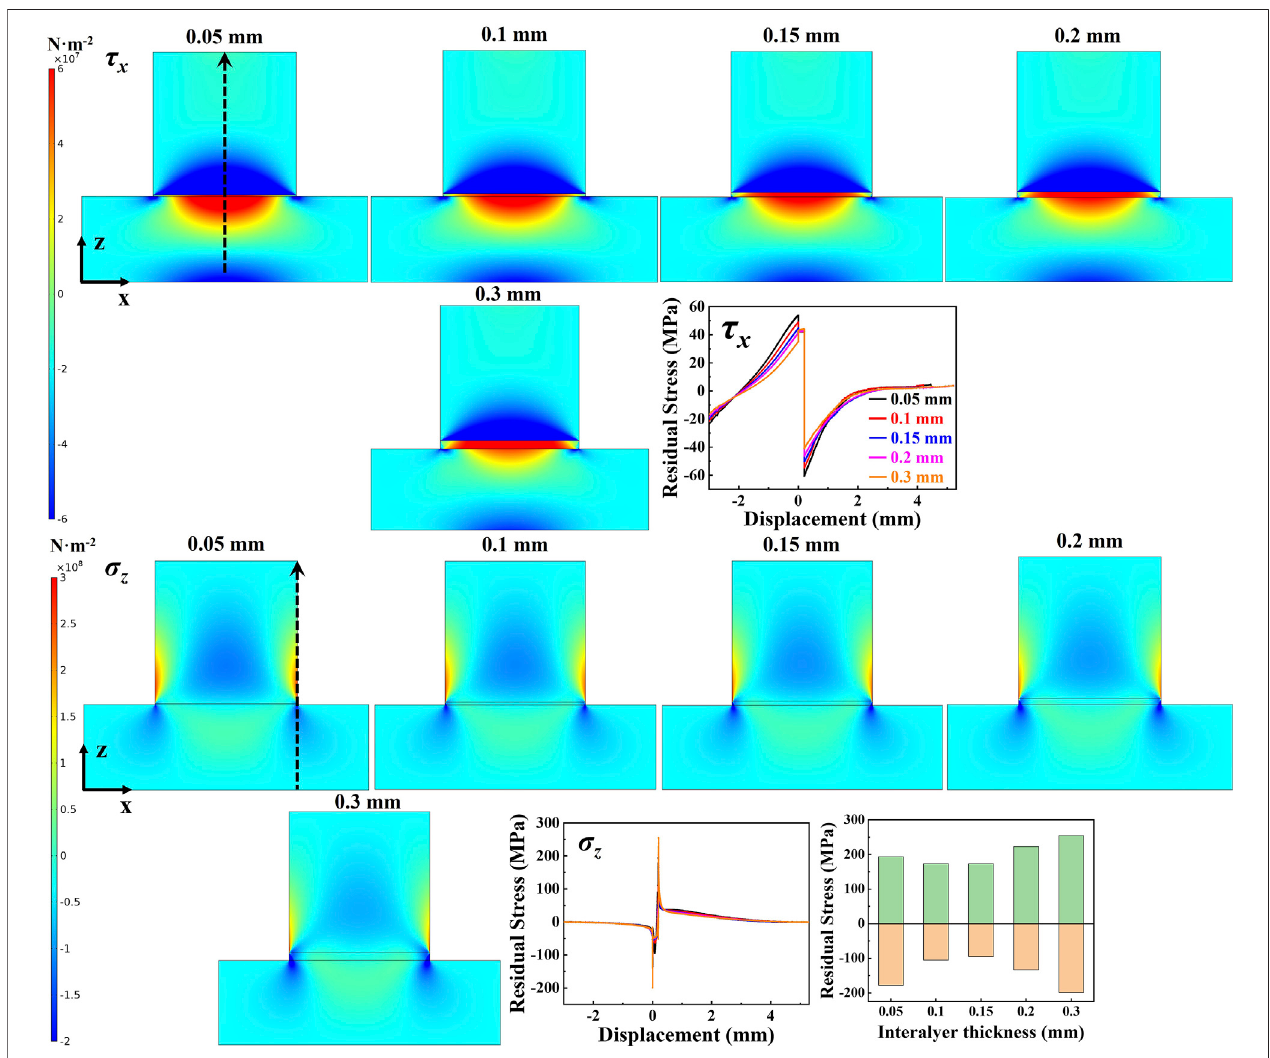
FIGURE 4 | τ x and σ z distribution in C/C-Nb joints brazed with different G-Cu f interlayers differing in thickness.